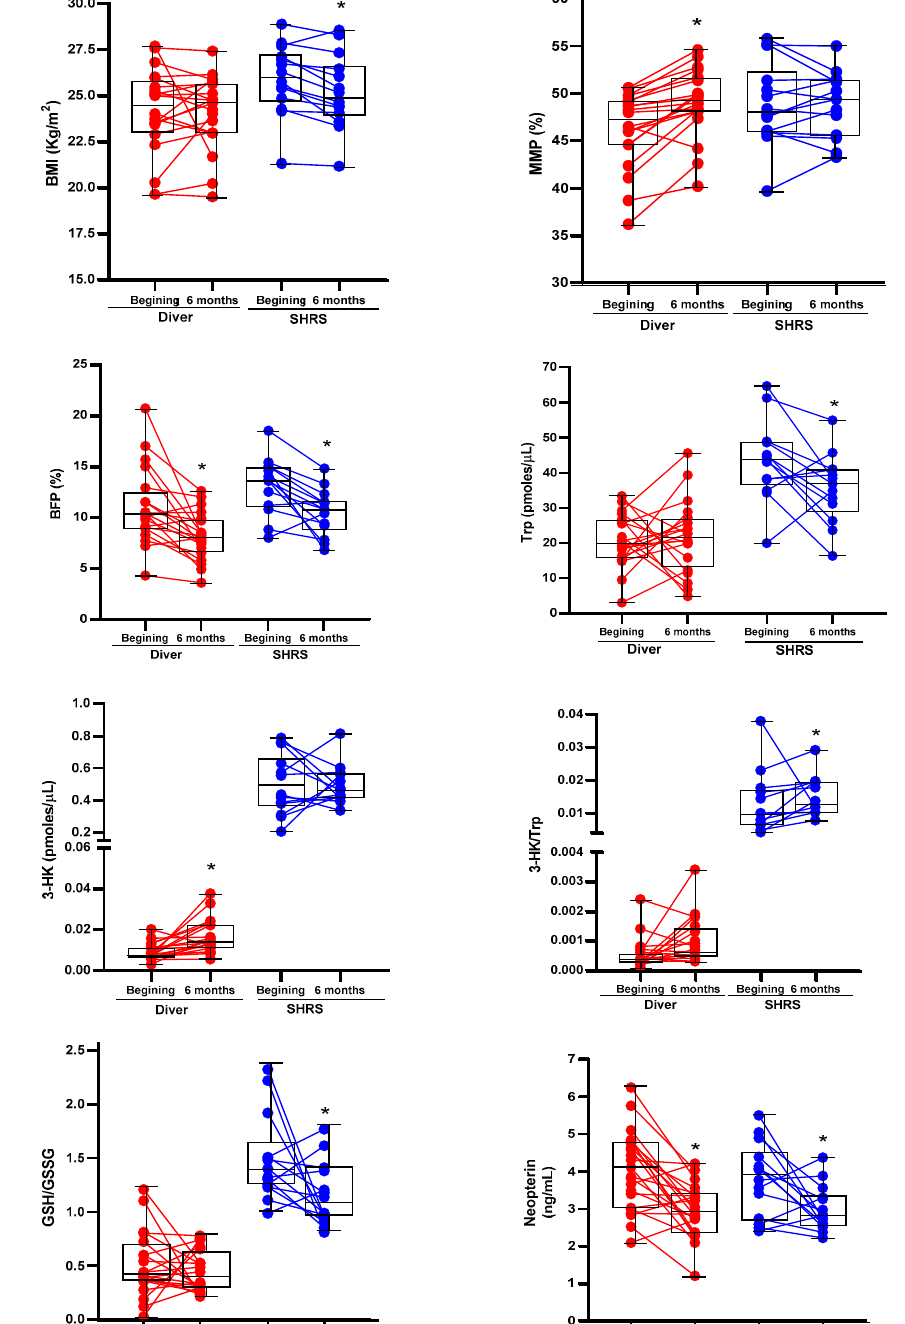
Figure 1. Boxplots associated with significant changes of BC, Trp catabolism and redox environment of divers and SHRSs after six of the military training program. The graphs also include the values at the beginning and at the end of program for each individual. * p < 0.05 vs. beginning, based on Wilcoxon signed-rank test.